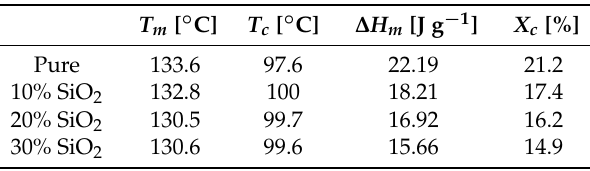
Figure 2. SEM picture of the silica NPs entrapped in the polymer matrix after a single passage through the microchannel (scale 300 nm). Some silica NPs are encircled in violet to be better visualized. Table 2. Properties of the composite material at increasing amount of SiO 2 , derived from the DSC curves in Figure 3. T m : melting temperature. T c : crystallization temperature. ∆ H m : enthalpy of melting. X c :